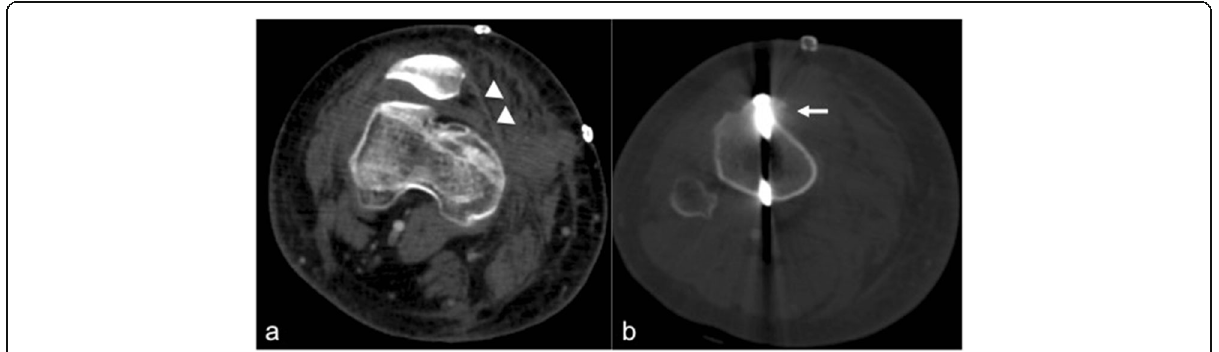
Fig. 9 Knee CT images in the early post-operative period in a 19-year-old male with history of patellar maltracking. a Axial CT image demonstrating MPFL reconstruction (arrow heads). b Axial CT image showing tibial tuberosity transfer surgery with screw placement